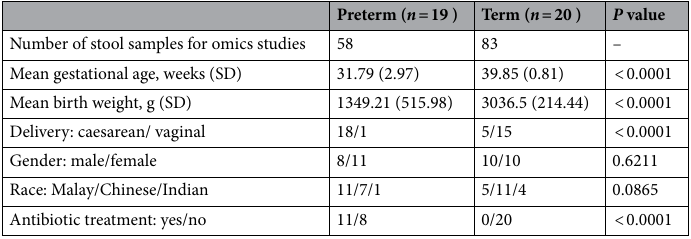
Table 1. Demographics and characteristics of all infants studied. P values < 0.05 were considered as significant. t test for continuous data; Chi-square test for categorical